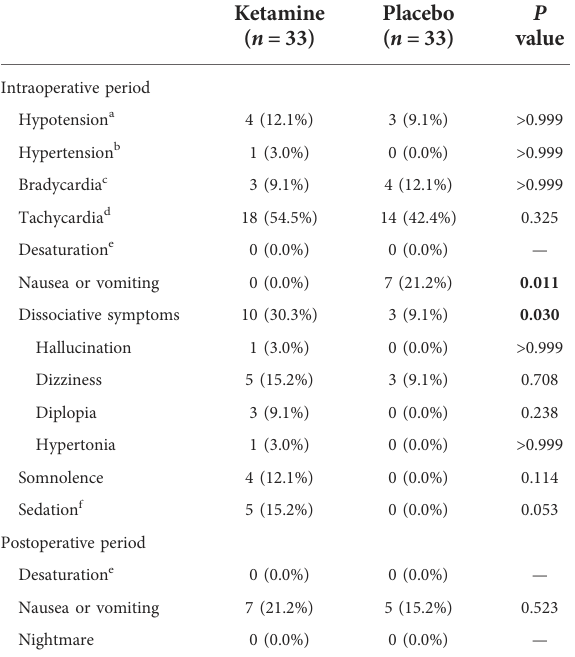
TABLE 5 Adverse